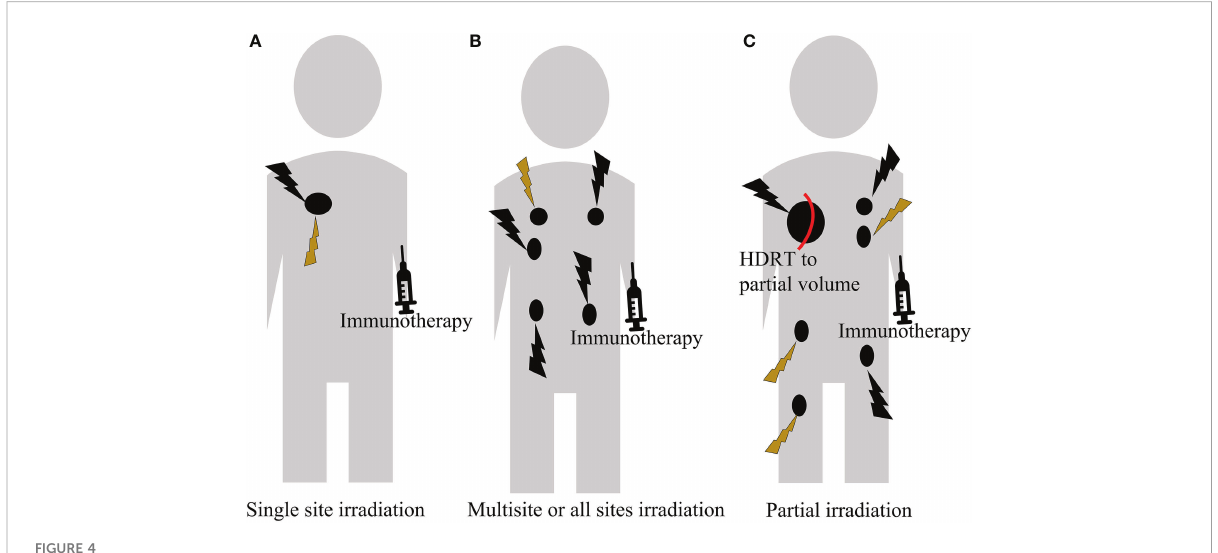
FIGURE 4 A personalized treatment regimen based on the patient ’ s performance status, clinical symptom, extent of tumor burden, and the immune type of the tumor microenvironment. (A) For a single tumor, HDRT can initiate T cell priming, followed by LDRT to modulate the tumor microenvironment. (B) For oligometastatic disease, HDRT can be delivered to all lesions. If it is infeasible and intolerable, it can be supplemented with LDRT. (C) For extensive metastatic disease, partial volume HDRT can be delivered to one or a few lesions, followed by LDRT to other